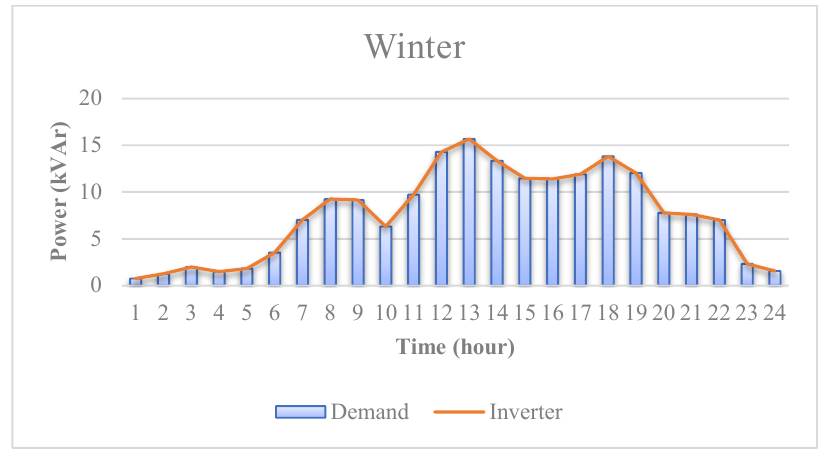
Figure 15. The reactive power support by smart inverters in winter.